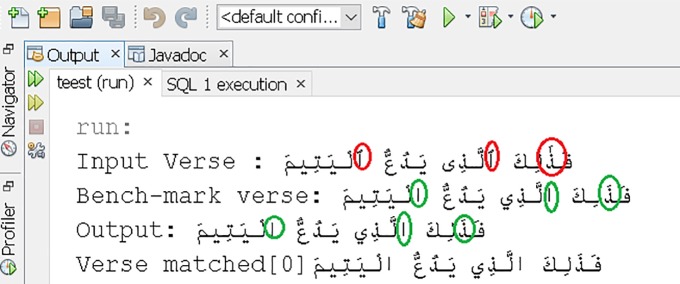
Prototype snapshot.